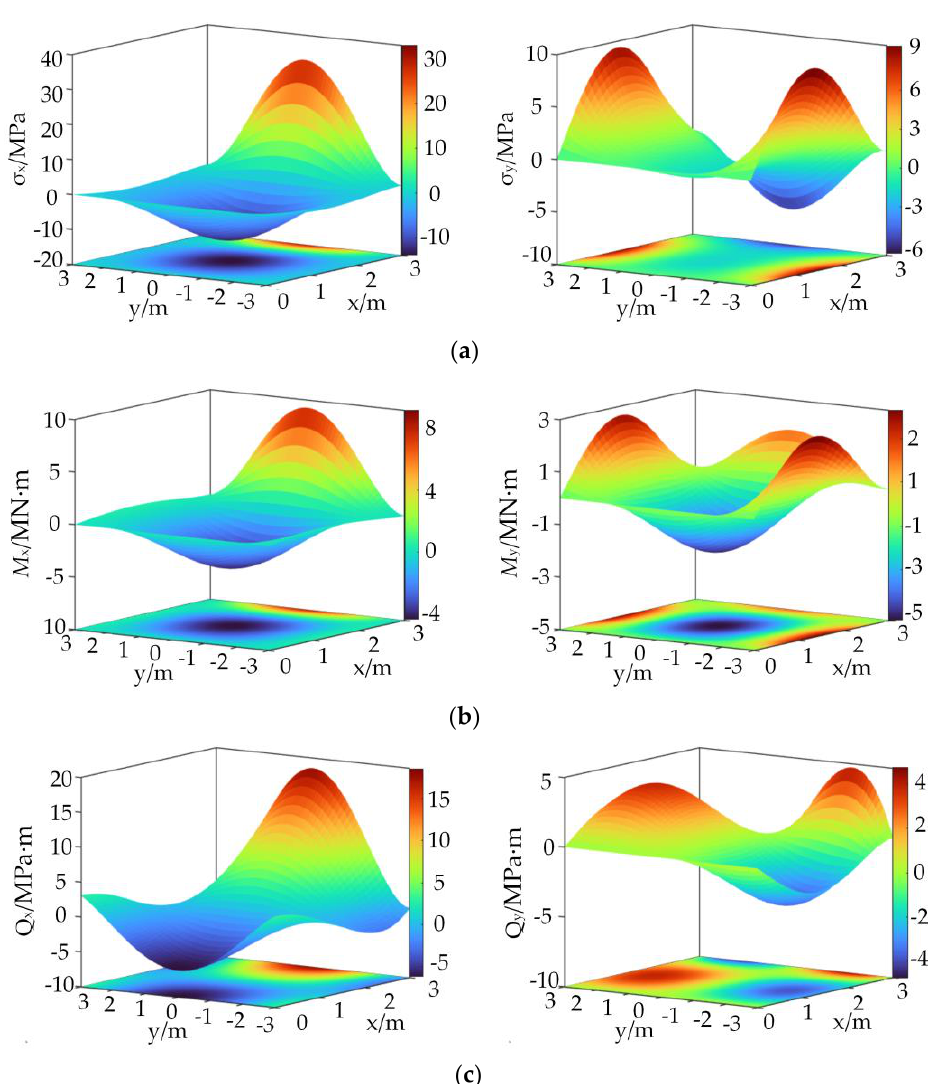
Figure 3. Distribution of roof stress and internal force in heading face: ( a ) stress; ( b ) ending moment; ( c ) transverse shear stress.